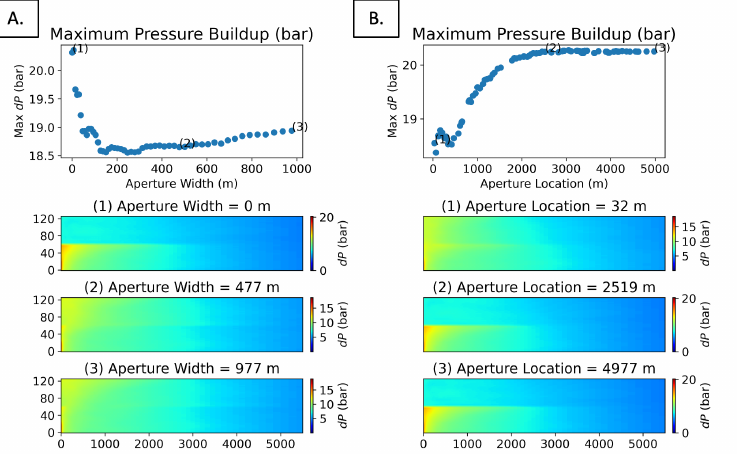
Figure 9. The relationship between maximum pressure buildup and ( A ) the aperture and ( B ) the aperture location. The pressure buildup fields of the annotated examples in the fitted data are illustrated as